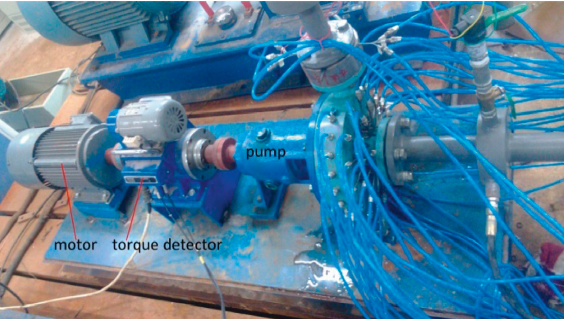
Figure 5: Multichannel pressure sensor integrated